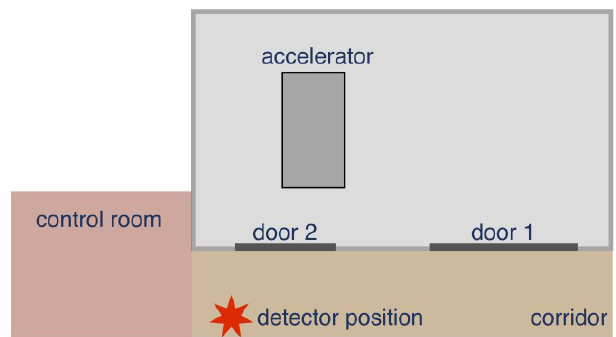
Figure 5. At the Helios Klinikum, Aue, Germany, a measurement next to the control room was performed, while at the same time an experiment was carried out inside the treatment room.